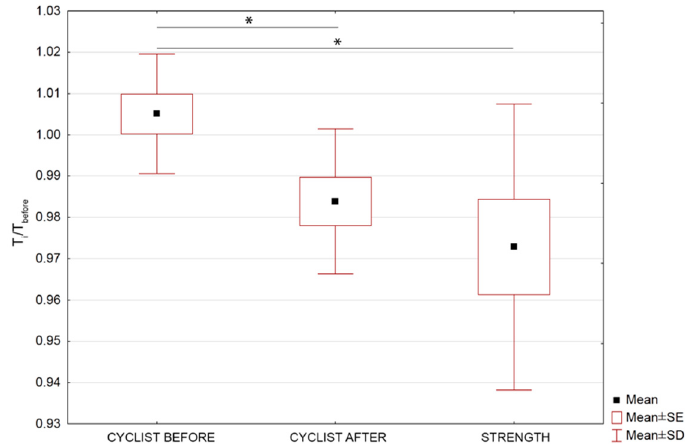
Figure 5. Normalized mean body surface temperature changes for studied group of cycling sportspersons before and after one training year and strength of sportspersons as a reference level performed after 10 min of training. Statistically significant changes were marked as * on the graph with p < 0.05.